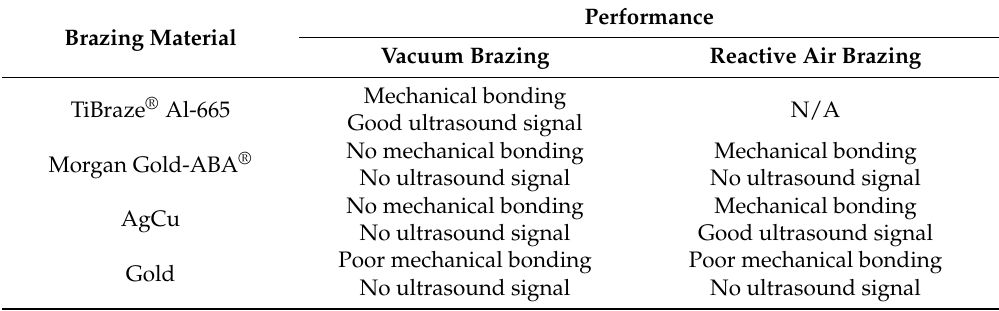
Table 3. Summary of room temperature performance of brazing materials bonded to LiNbO3 by vacuum brazing or reactive air